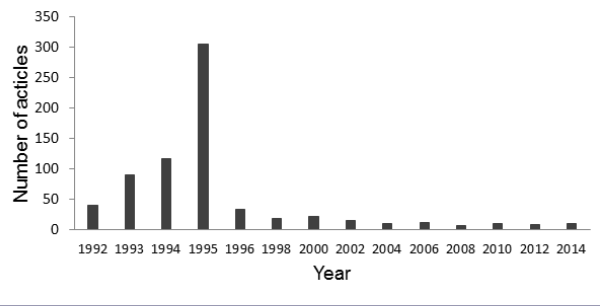
Fig. 2 . Number of articles per year in the Netherlands.